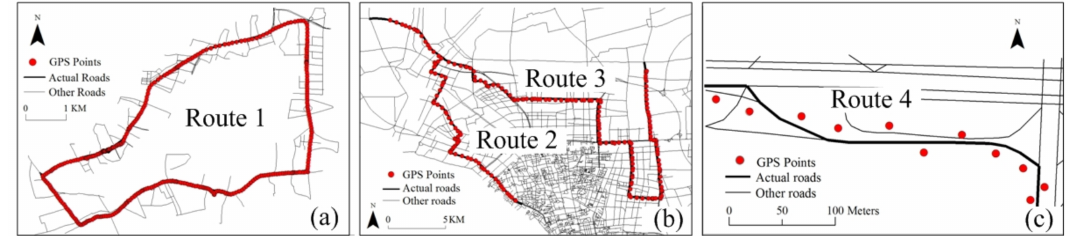
Figure 1. Four actual routes on three datasets ( a – c